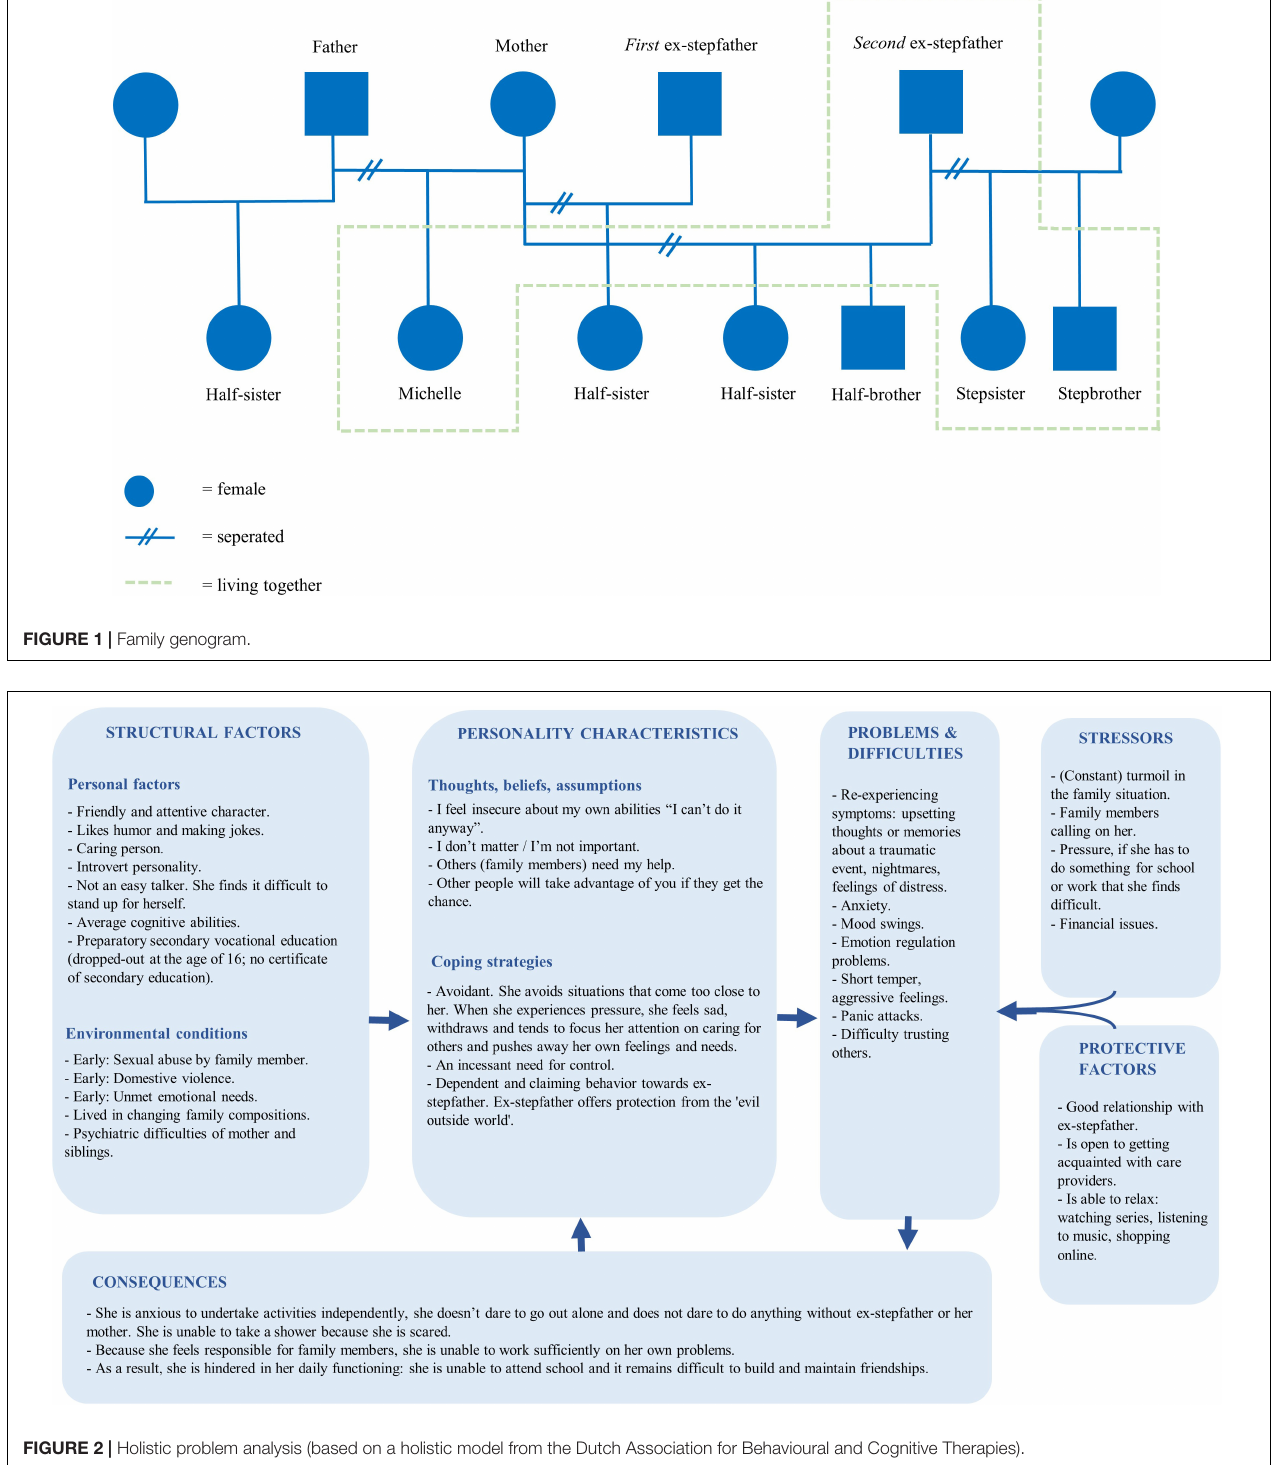
necessary, could help immediately. After 2 weeks, when Michelle was calmer again, the situation was re-evaluated with Michelle and family members and with her mother’s therapist. Together